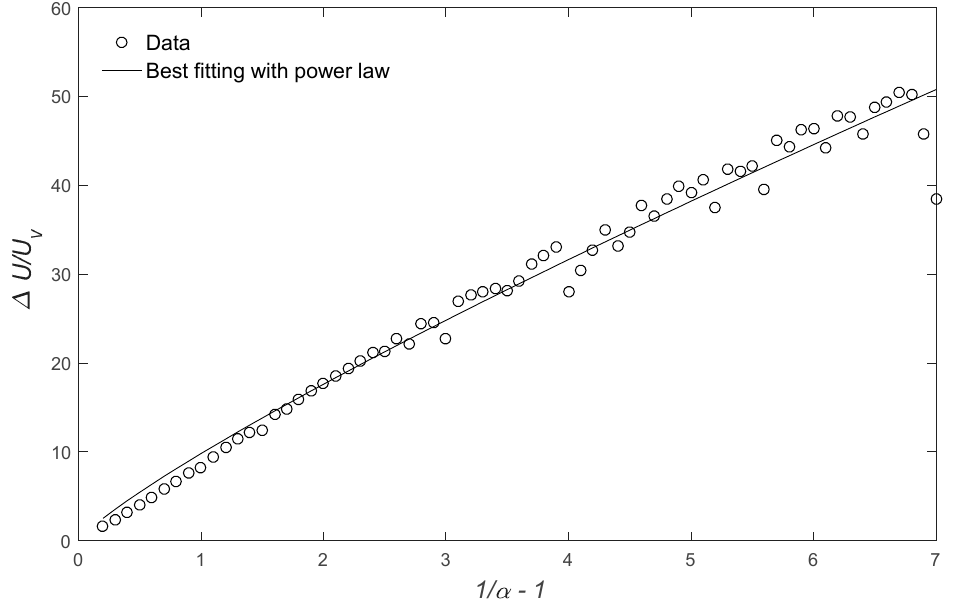
Figure 3. Relation between ∆ U / U v and 1/ α − 1 using the first-order closure model.